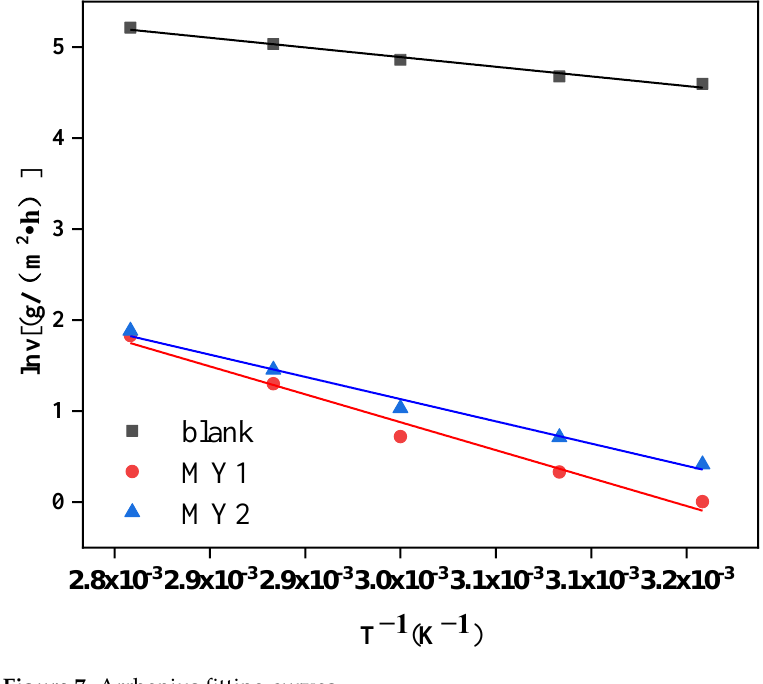
Figure 7. Arrhenius fitting curves. Table 3. Effect of corrosion inhibitor on activation energy of corrosion reaction.